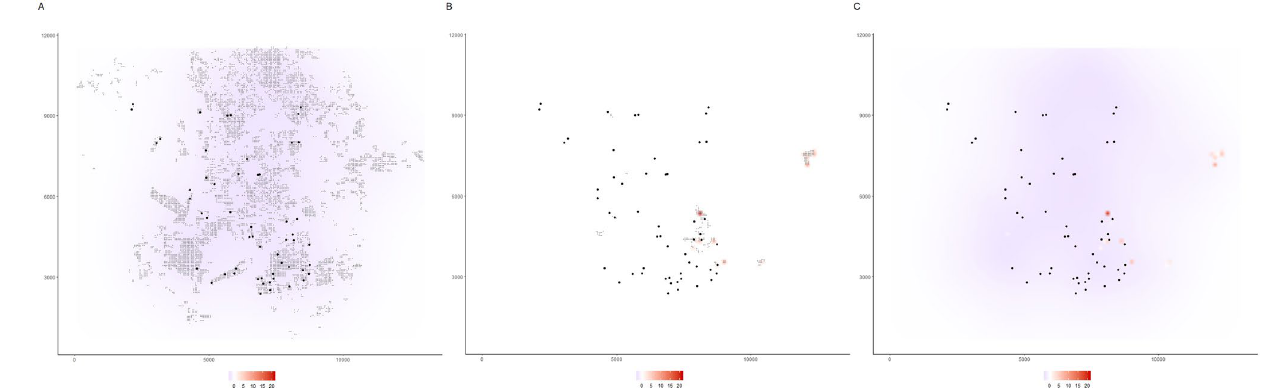
Figure 3. Maps of the predicted effect estimated by the Fsiland method obtained with the function plotFsiland.land() . The SIF model was estimated using the command: resF = Fsiland(Cmoth ~ trait + conv + org, land = landCmoth,data = dataCmoth) . The three maps A, B and C were obtained with the command plotFsiland.land(resF, land = landCmoth, data = dataCmoth, var = var), var equal to 1,2 and 0 respectively. The black points represent locations of response variable observations. In graphics A and B, the gray points are the pixels where conventional and organic orchards are present, respectively. The response surface represents the cumulative effect of the conventional orchards in graphic A, the organic orchards in graphic B and the global landscape in graphic C. At the bottom margin, the bar color gives the effect intensity. In the figure A, conventional orchards had negative effects at large scale. In figure B, organic orchards had positive effects positive effects at small scale. In figure C, global landscape had an overall negative effect except on spotty